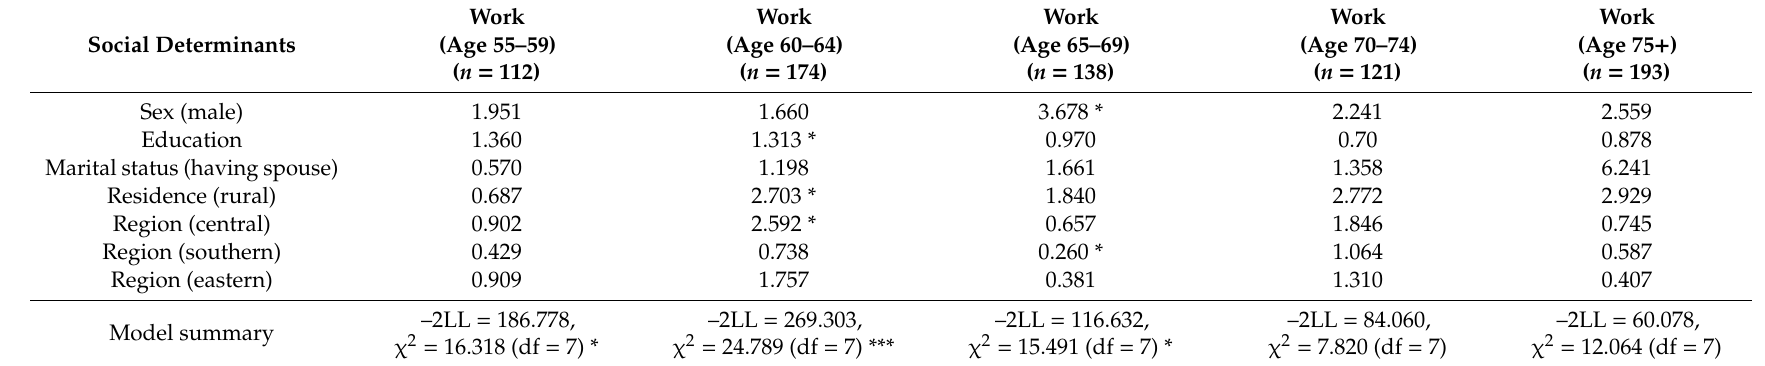
Table 2. Employment indicators and social determinants by logistic regression.